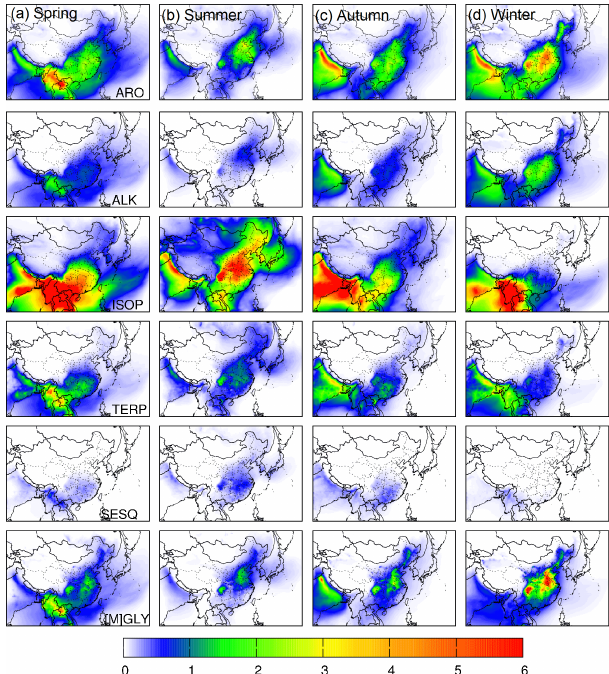
Figure 6. Predicted seasonal average SOA concentrations due to contributions from different precursors in (a) spring (March, April and May), (b) summer (June, July and August), (c) autumn (September, October and November), and (d) winter (December, January and February) 2013. Units are µgm − 3 . ARO: aromat- ics; ALK: alkane; ISOP: isoprene; TERP: monoterpenes;